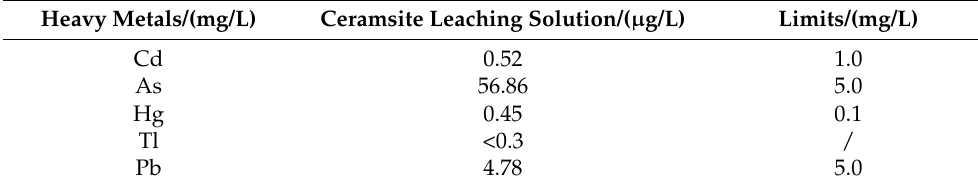
Table 3. Heavy metal concentration and the national